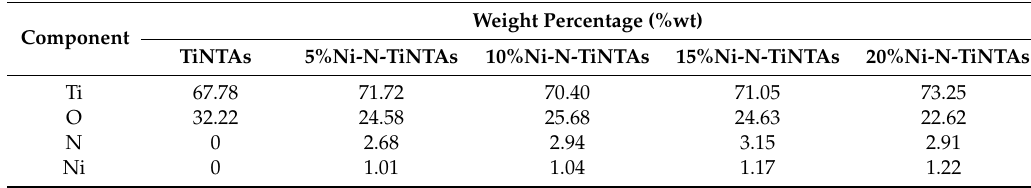
Table 1. EDX results of undoped TiNTAs and doped